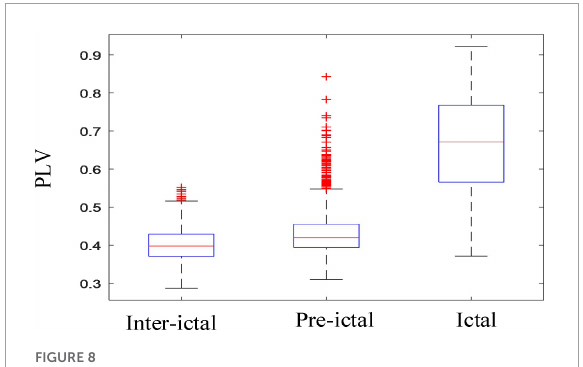
FIGURE8 Comparisons among the three groups in synchronization (inter-ictal vs. pre-ictal, inter-ictal vs. ictal, and pre-ictal vs. ictal). Boxplots of PLV in three groups; PLV was extremely heightened during the seizures. There were much more outliers in the pre-ictal group than inter-ictal group (the red “+” represents outliers).